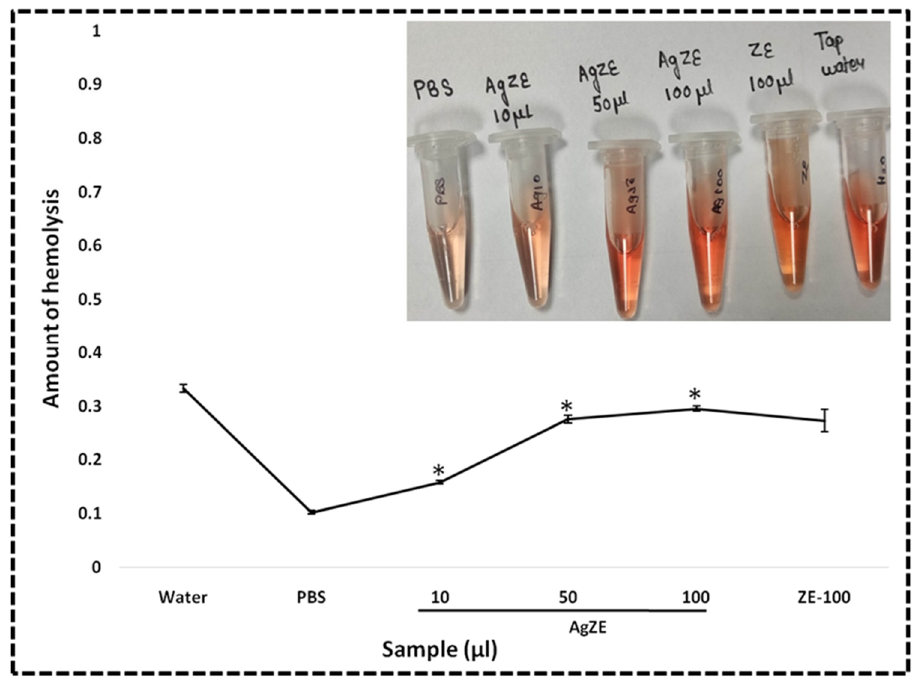
Figure 11. Hemolytic assay in vivo using mice blood indicating the hemocompatible nature of the AgZE (5–100 µL). The inset picture represents the amount of hemolysis (with respect to red color intensity) is more in positive control (tap water) compared to other treatments, whereas no hemol- ysis is observed in negative control (PBS). Numerical values indicate the AgZE pellet amount taken where 1 µL = 0.23 µg/mL of silver as per ICPOES study. These experiments are performed thrice and represented as the mean ± SD. Significant differences from negative control are observed (* p <